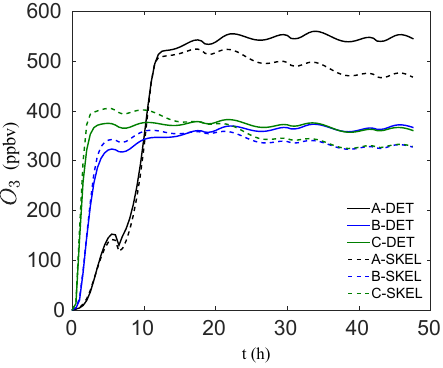
Figure 4. Detailed and skeletal ( N sp = 54) ozone profiles for cases